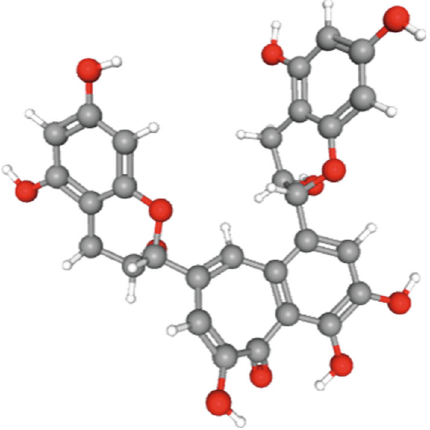
Figure 8: Molecular structure of Thea fl avin.